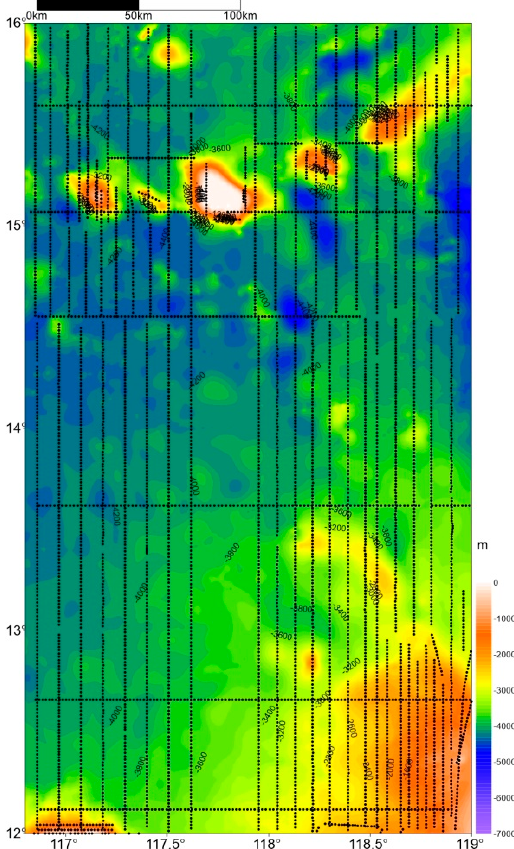
Figure 4. Survey area profile plot.